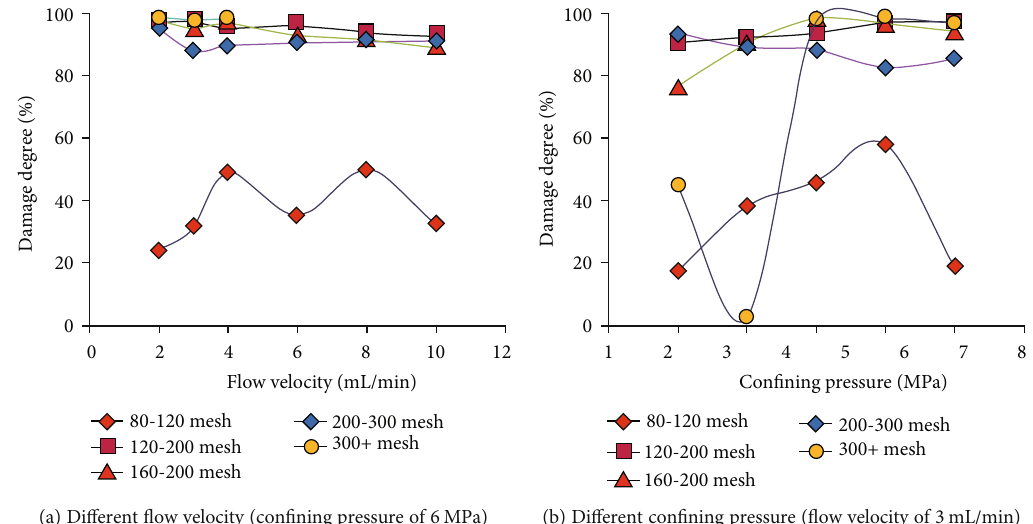
Figure 13: Permeability loss rate at di ff erent